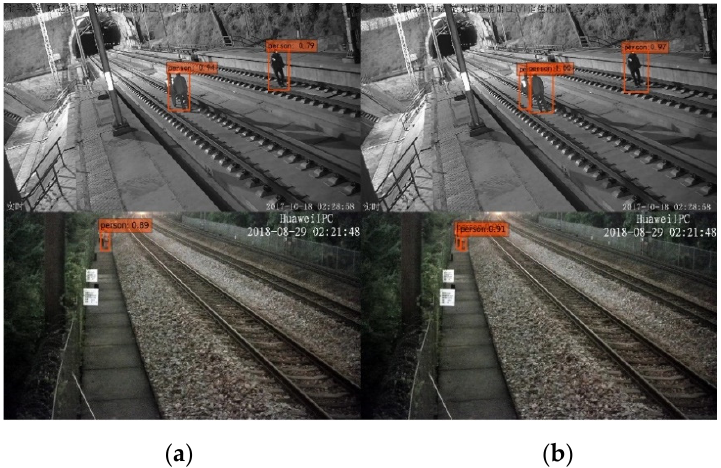
Figure 10. Comparison between the original SSD and our improved SSD. ( a ) Recognition effect of the SSD. ( b ) Recognition effect of the improved SSD.